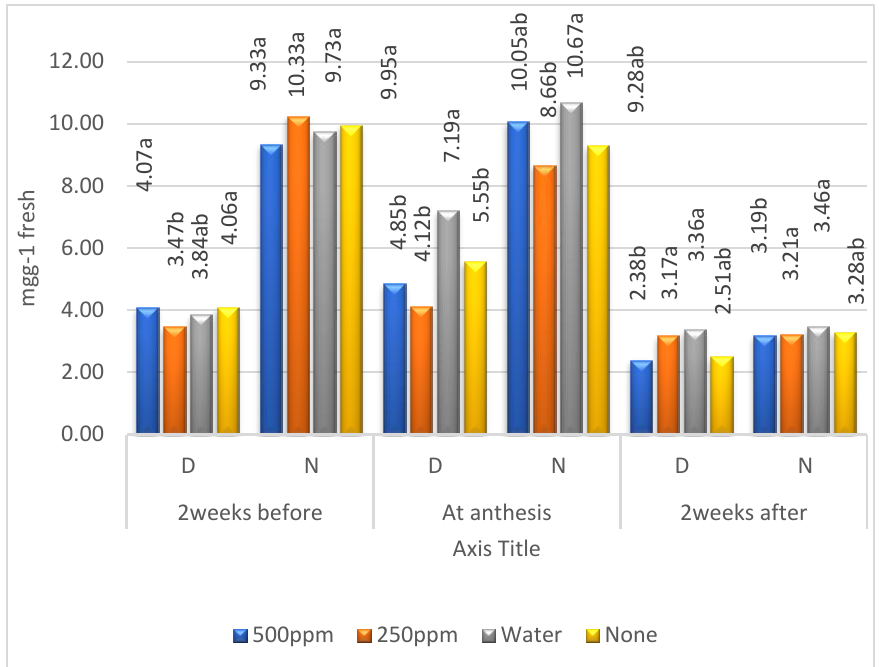
Figure 2. Combined means of soluble protein for the levels of zinc under drought stress (D) and irrigation (N); means followed by the same letter in each environment are not significant at the 0.05 level of probability according to LSD test.